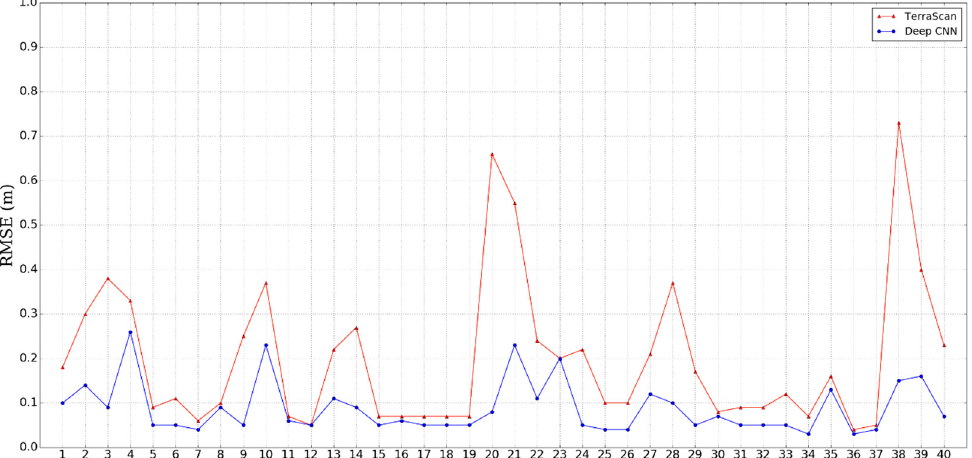
Figure 8. Comparison of root mean square error (RMSE) between the generated DTM with the ground truths.